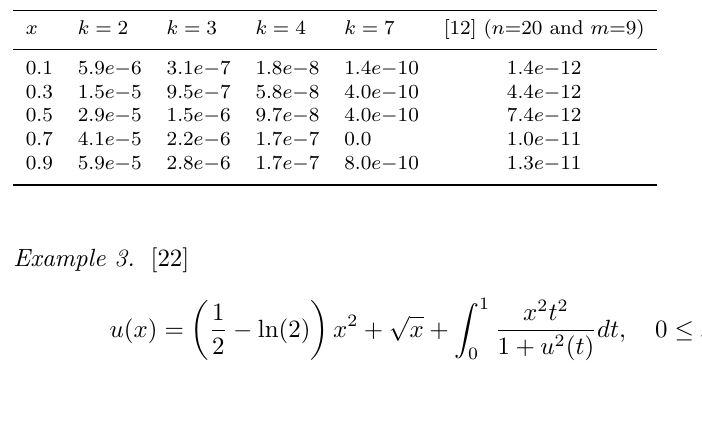
Table 2. Absolute error of Example